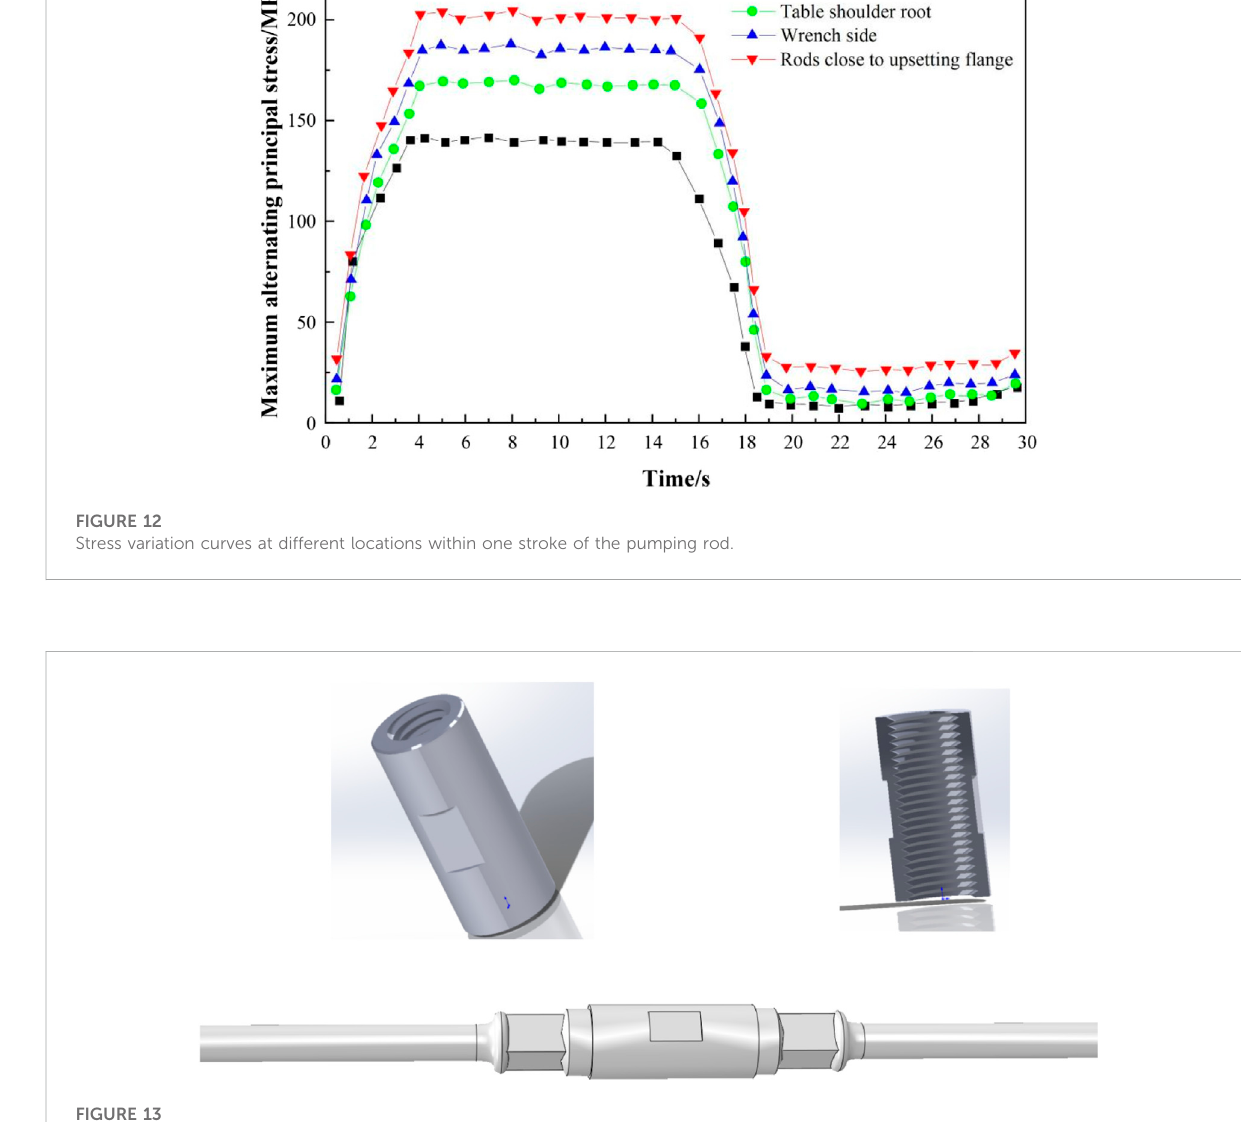
FIGURE 13 Connection diagram of joint and pumping rod.